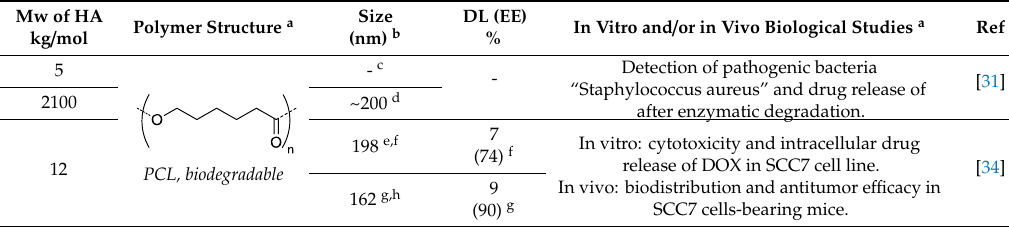
Table 1. HA- b -polymers nanocarriers.